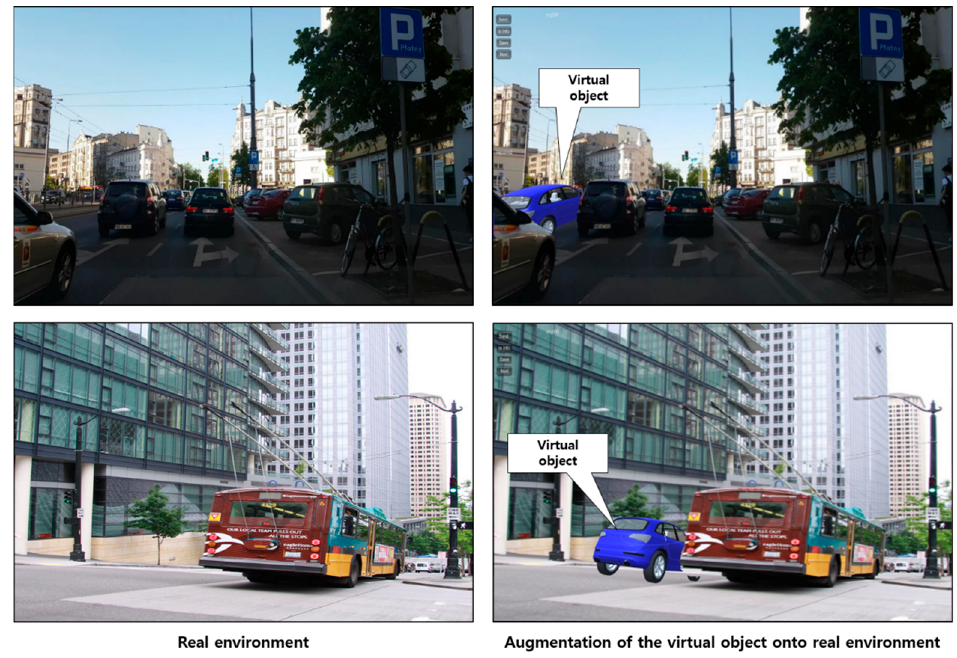
Figure 17. Application of the proposed approach to IoT visualization in a smart home.